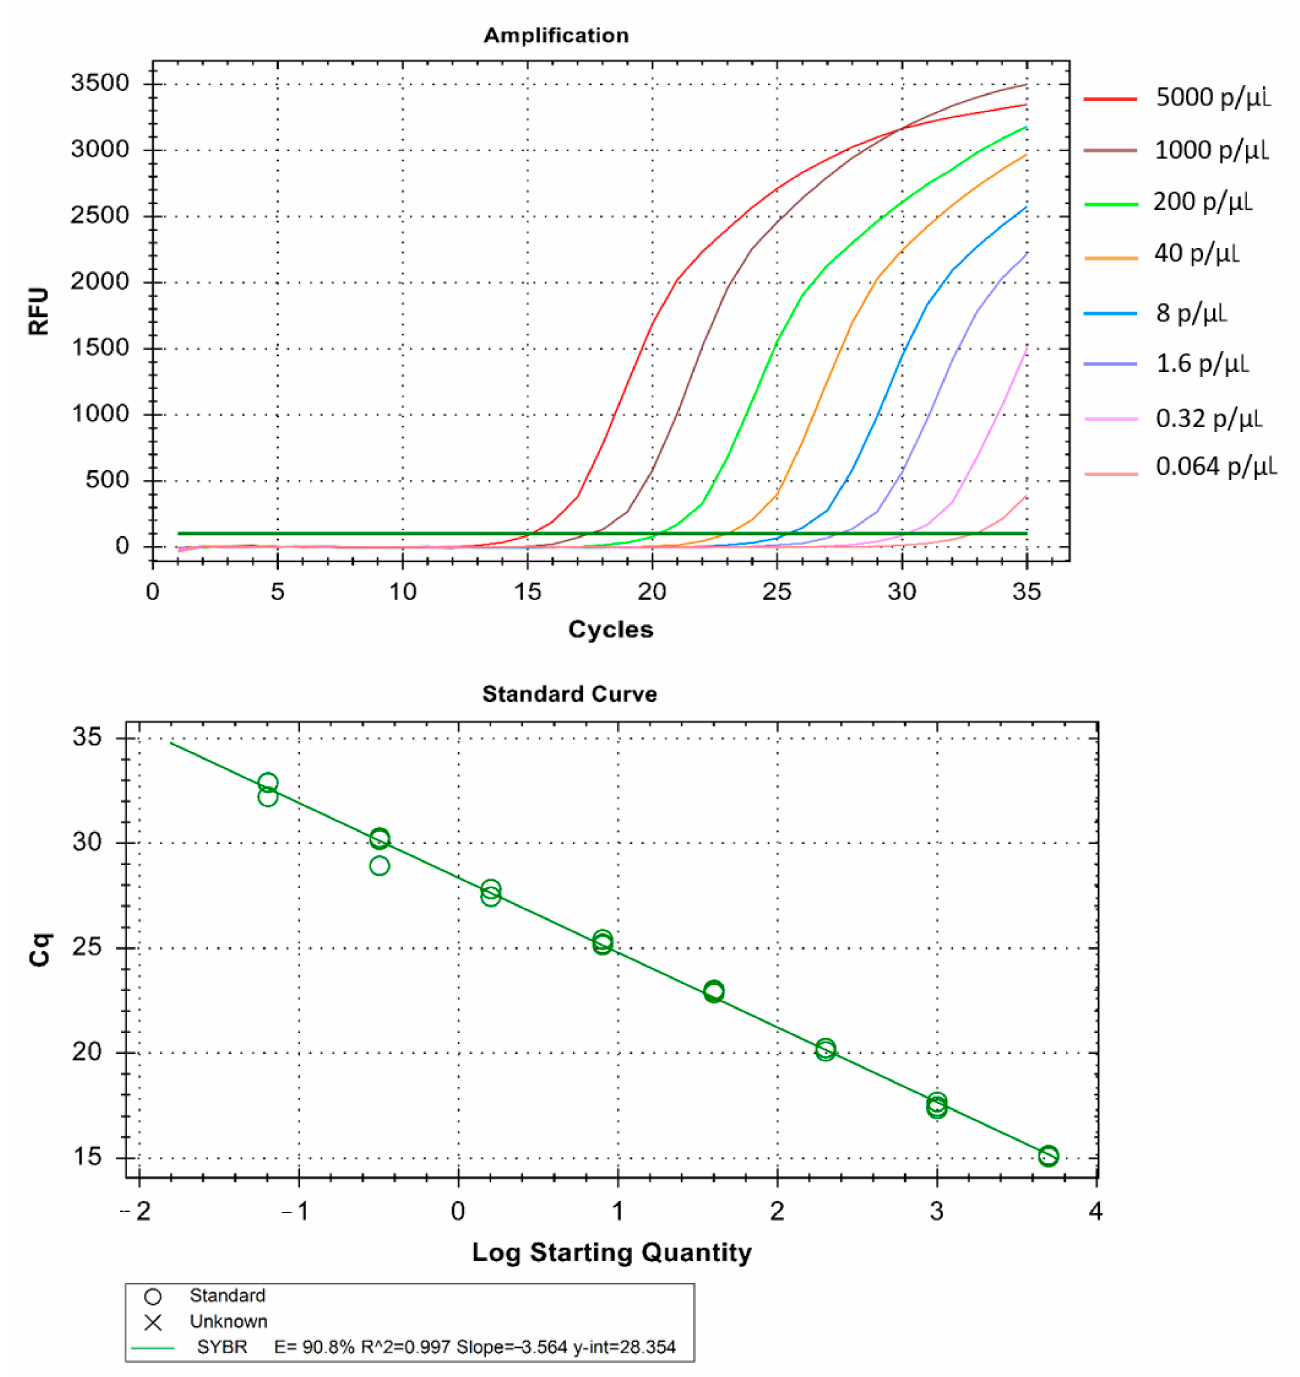
Figure 5. Technical performance and range of detection of the Pf real-time SYBR green PCR. DNA was extracted from MRA- 102 3D7 strain cultured in vitro, ranging from 5 × 10 3 to 6.4 × 10 − 2 parasites/ µ L, and subjected to real-time SYBR green based PCR. Amplification curves are depicted by different colors each containing a different parasite load. The standard curve has been made by the ct values obtained from the assay plotted against the logarithmic parasite concentration in a linear regression curve fit analysis (R 2 = 0.997, E =